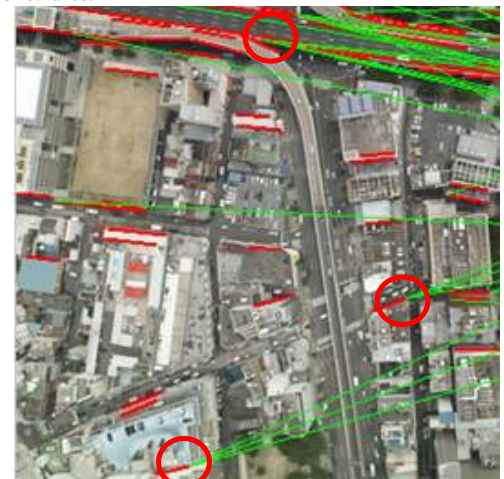
Figure 19. Mismatched points in corresponded point detection results